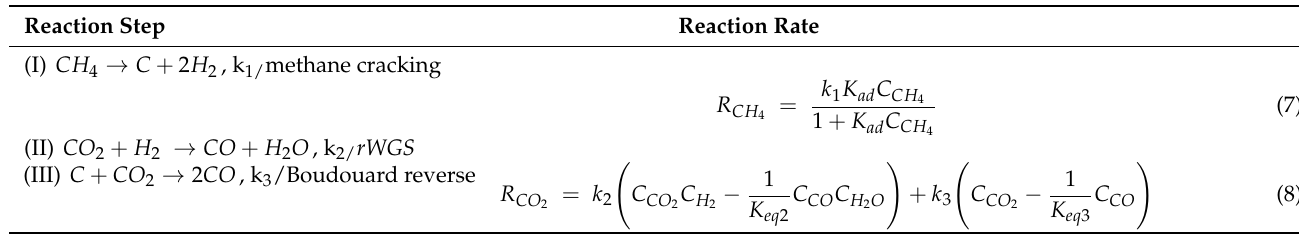
Table 1. Mechanism and reaction